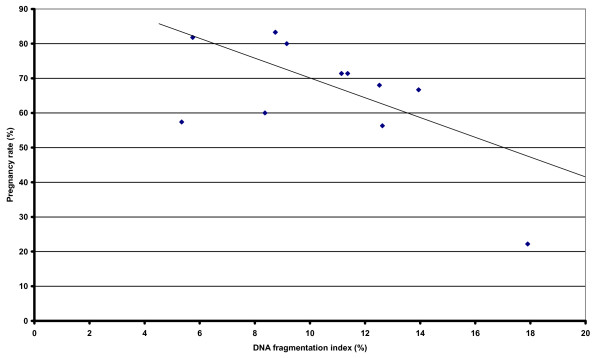
Relationship between DNA fragmentation rate (DFI) and pregnancy rate (%) following artificial insemination with cooled, transported stallion spermatozoa from the ejaculates tested in this study (n = 37). The line of best fit for the data points is shown. Note: Statistics r = -0.63; P < 0.05).